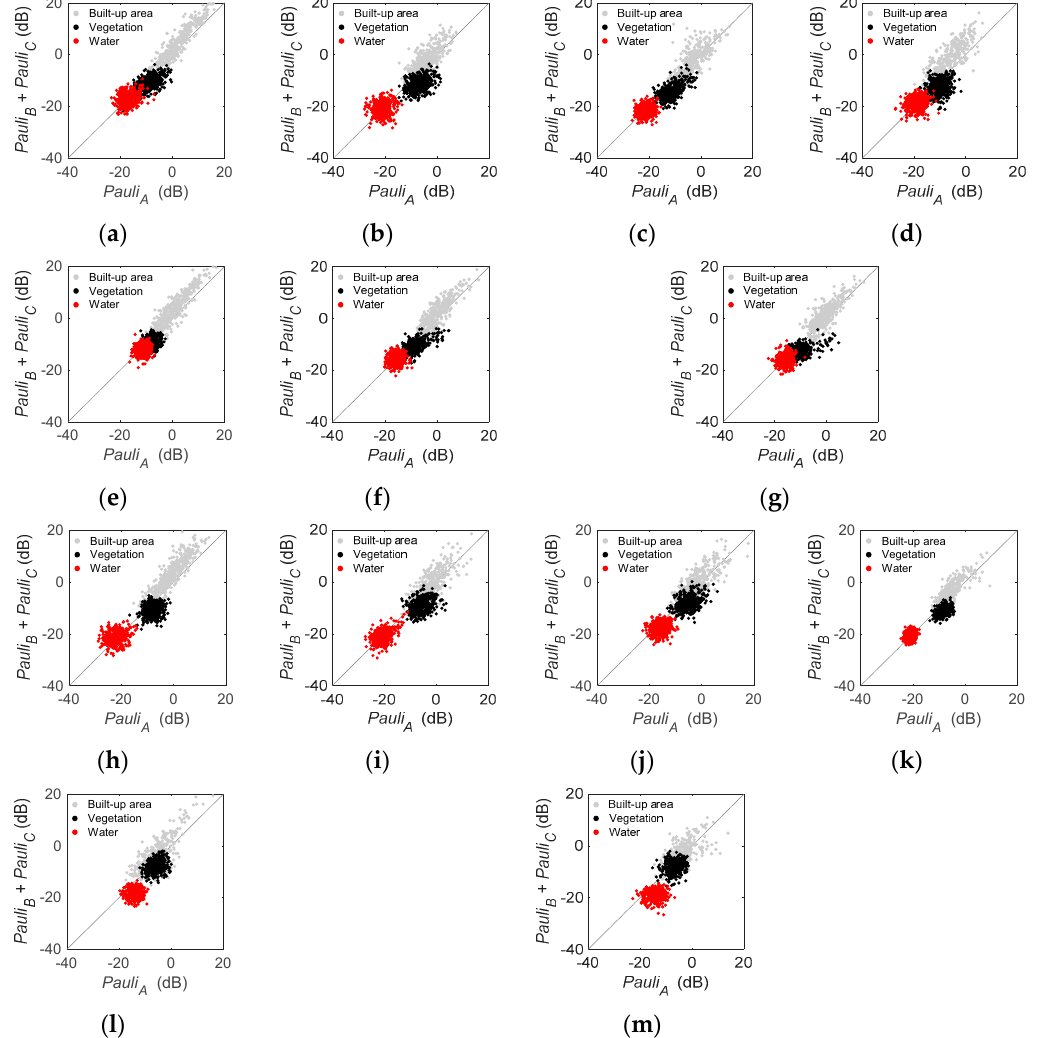
Figure 6. Scatter diagrams of built-up areas, vegetation, and water in Pauli-decomposed powers. ( a ) GF-1703, ( b ) GF-1710, ( c ) GF-1712, ( d ) R2-0903, ( e ) A2-1603, ( f ) A2-1610, ( g ) A2-1612, ( h ) GF-1702, ( i ) GF-1705, ( j ) GF-1708, ( k ) R2-1607, ( l ) A2-1504, and ( m ) A2-1601.